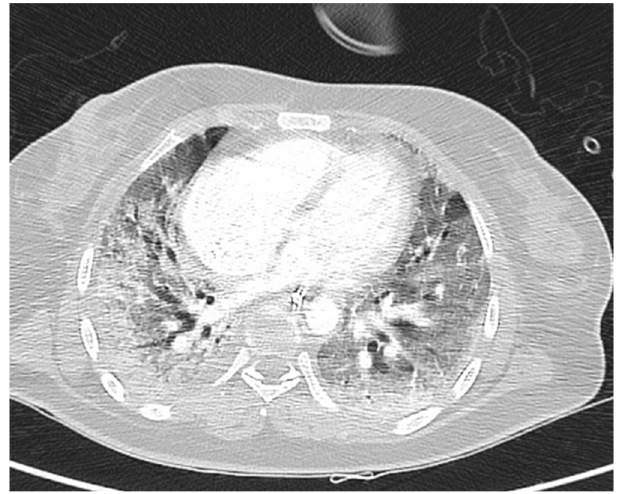
Figure 1. Bleomycin-related pulmonary toxicity: in this CT scan, bilateral severe fibrosis extended to all lung fields is represented. A 55-year-old woman experienced this fatal toxicity at the end of ABVD therapy for 6 cycles (with which she obtained CR).